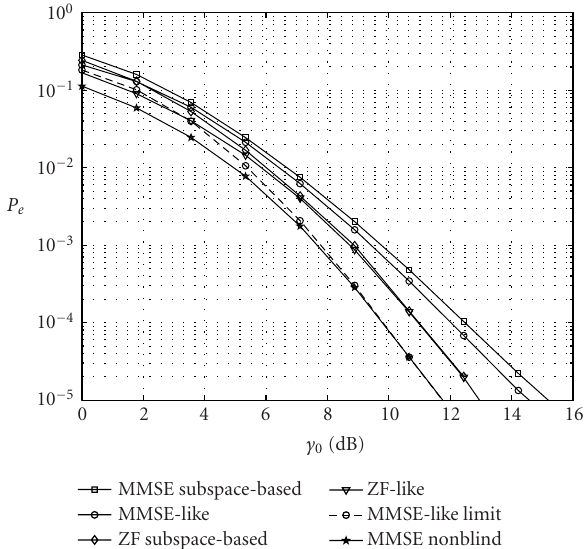
Figure 12: Probability of error for both soft integration and max- imal ratio combiner in a noncooperative scheme: K = 4, M = 8, N = 4, n t = 2, n r = 2, Q = 1300, P = 1500, and Q 2 =